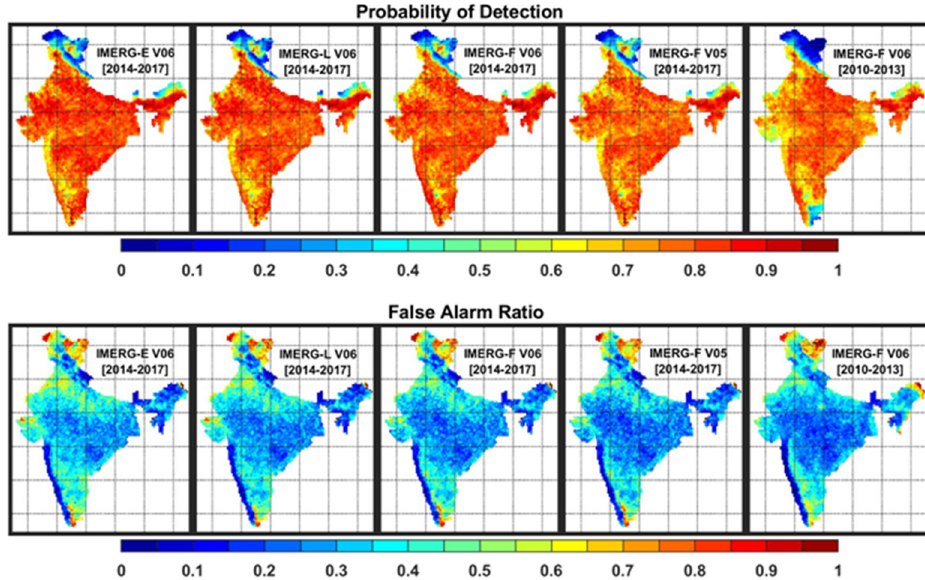
Figure 9. Spatial distributions of probability of detection and false alarm ratio in the detection of rainy days from the IMERG estimates as compared to the rain-gauge-based data over India for the GPM (2014–2017) and pre-GPM (2010–2013) periods.